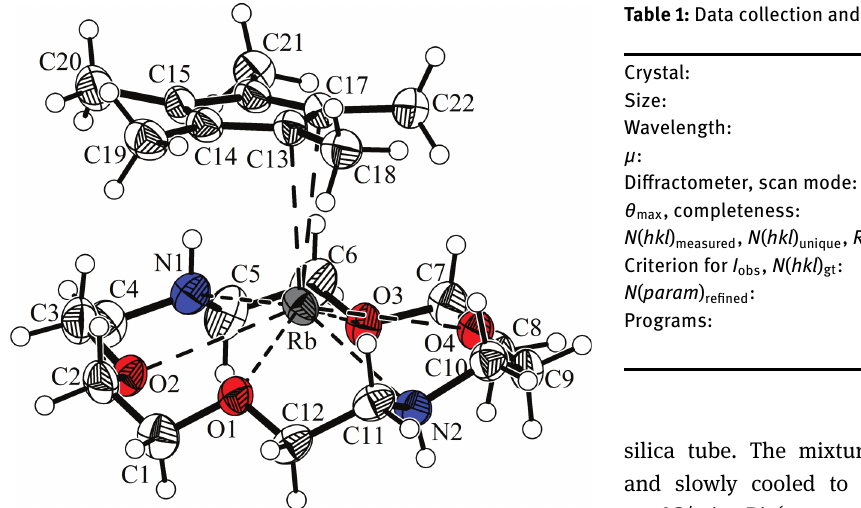
Table 1: Data collection and